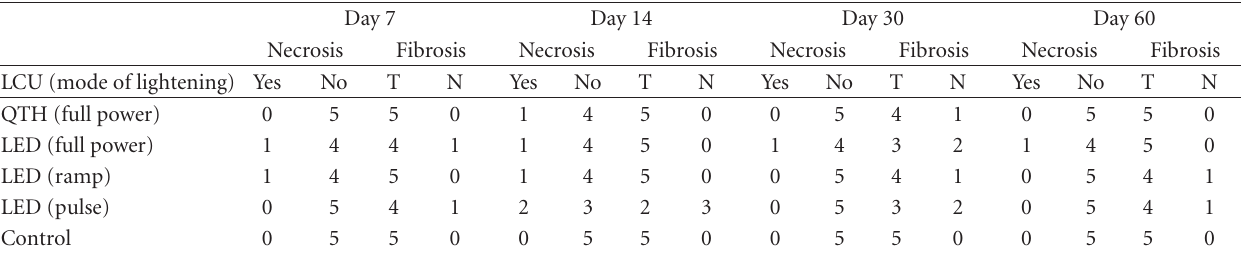
Table 5: Necrosis and fibrosis produced by light curing units in di ff erent modes of